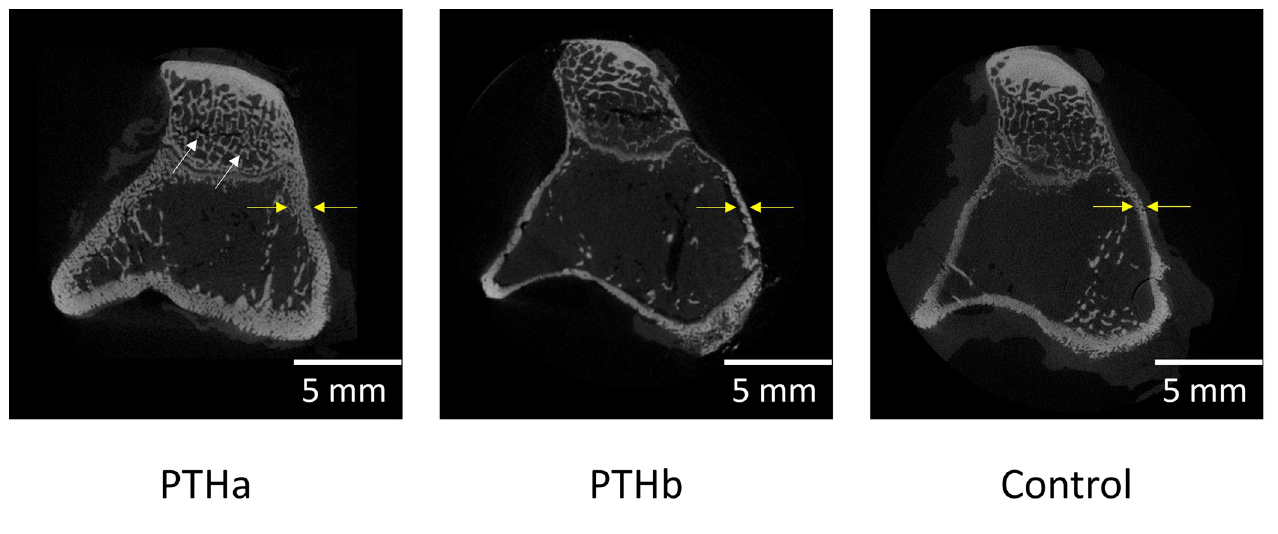
Fig 7. Micro-CT images of the proximal tibiae. In the PTHa group, the cortical bone width was thicker than those in the PTHb and Control groups (yellow arrows). The PTHa group had more trabecular bones, which were denser than those in the PTHb and Control groups (white arrows).